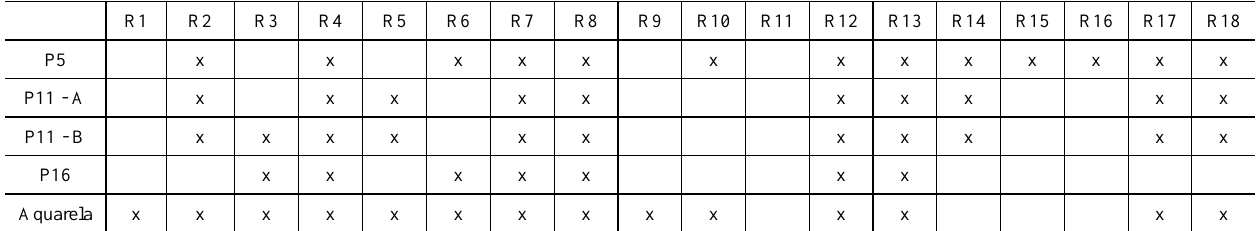
Table 3. Conformity of the five systems with the design